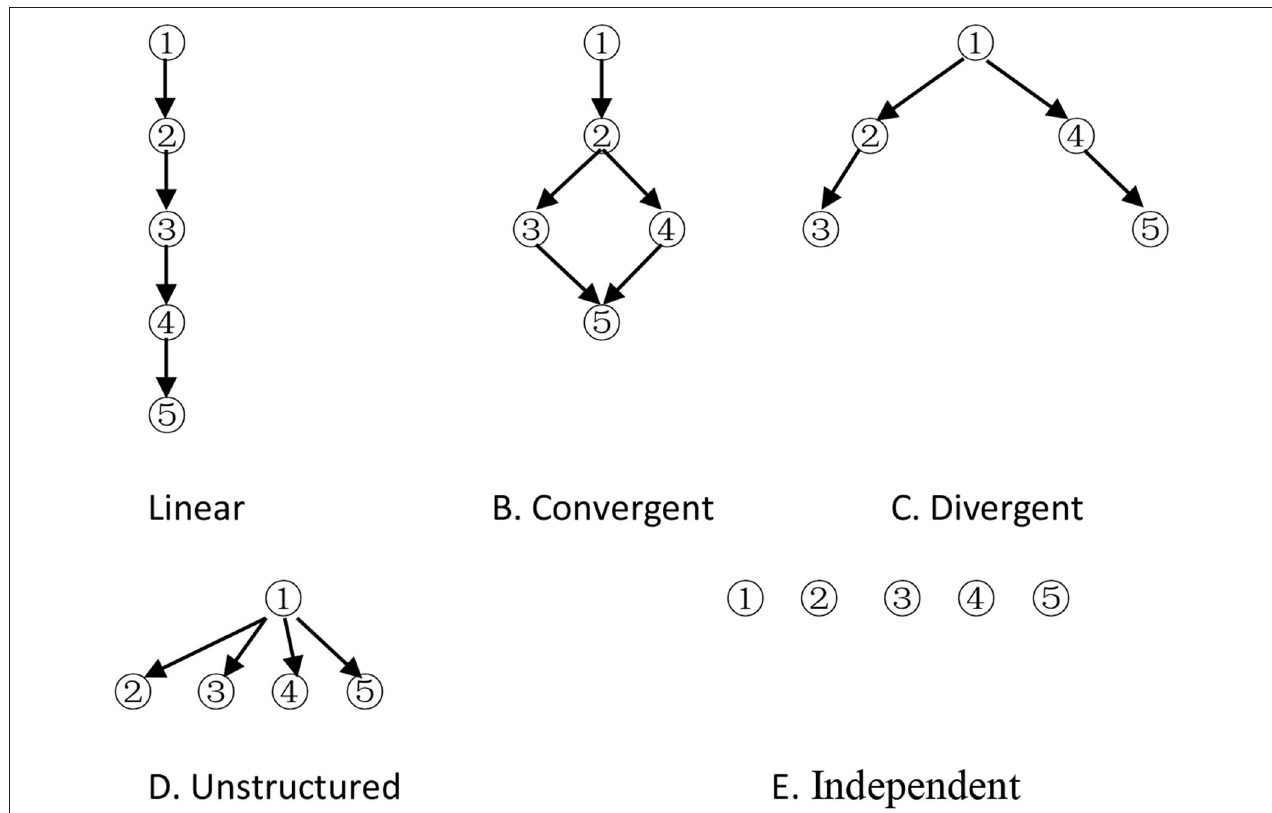
FIGURE 1 | Five different hierarchical